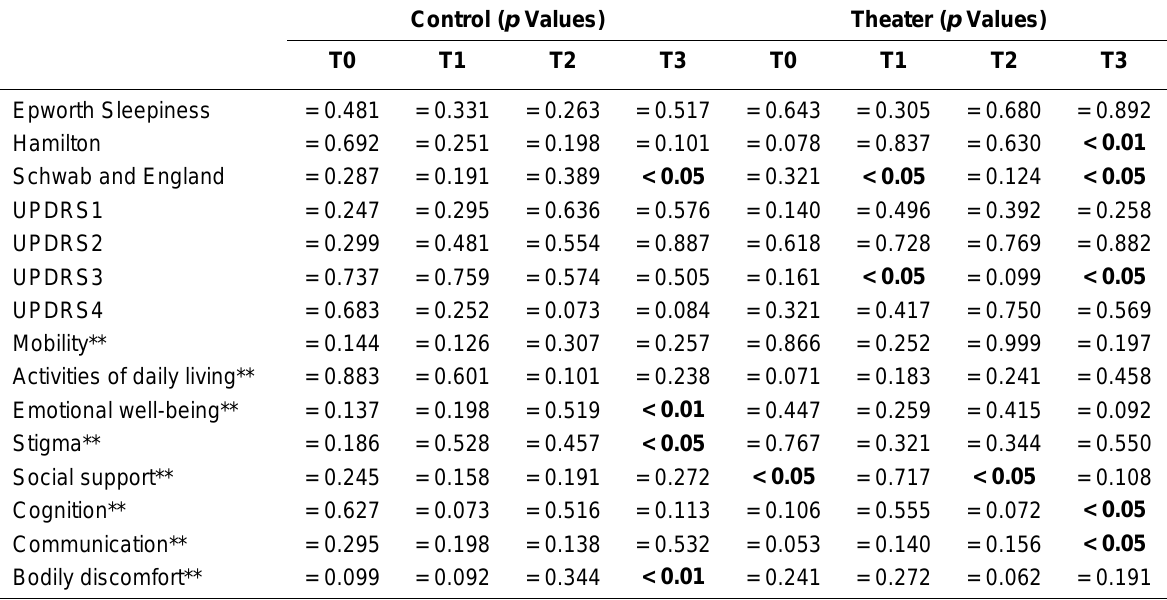
Results of Shapiro-Wilk Test of Normality Obtained for the Two Groups of PD Patients (Control Group and Theater Group) in all Clinical Scales (and Subscales) at the Four Time